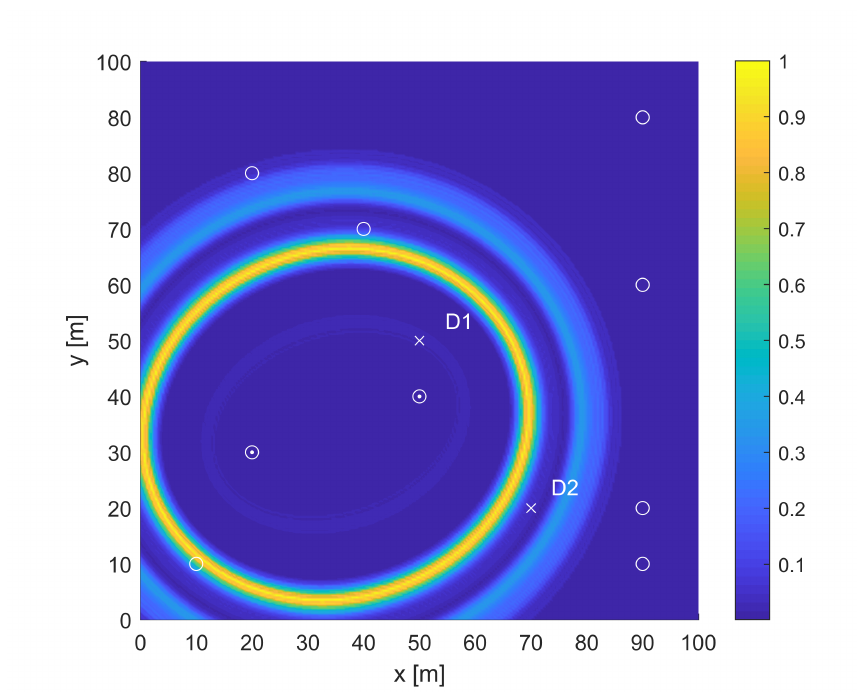
Figure 12. Ellipses based on two sensor locations using SLDV measurements with excitation at Sensor 5 and sensing at the measurement point corresponding to Sensor 4 location; excitation: 200-kHz tone burst; calculations using wave velocity (5300 m/s) corresponding to S0 mode